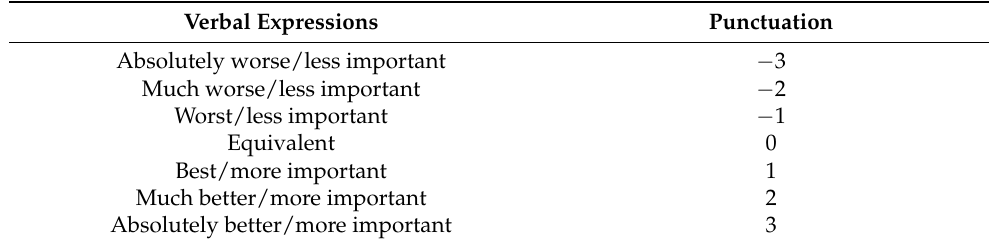
Table 2. Ordinal scale of importance.